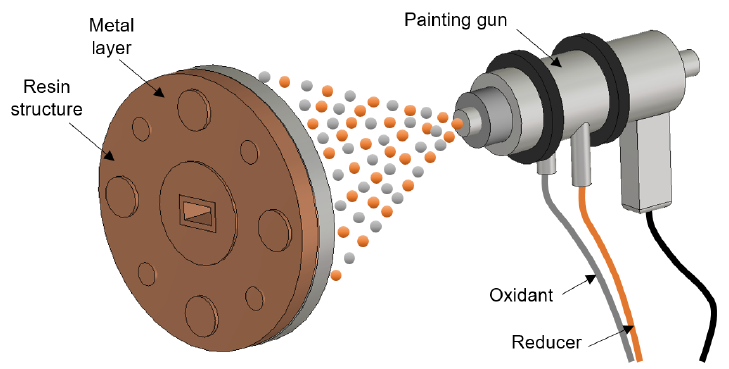
Figure 11. Spray metallization scheme developed by JetMetal [47].